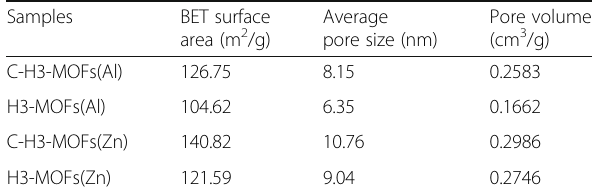
Table 1 Porous parameters of the samples